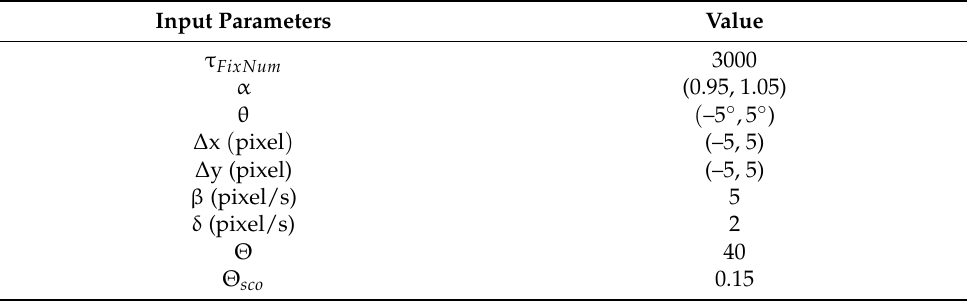
Table 1. Input parameters for the proposed